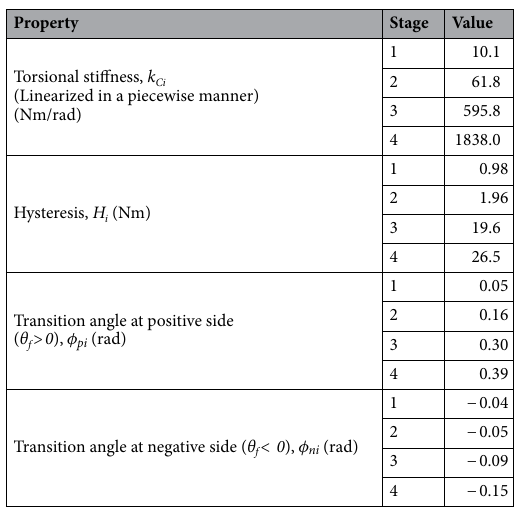
Table 1. Properties for the piecewise type nonlinearities based on the practical system 8,23